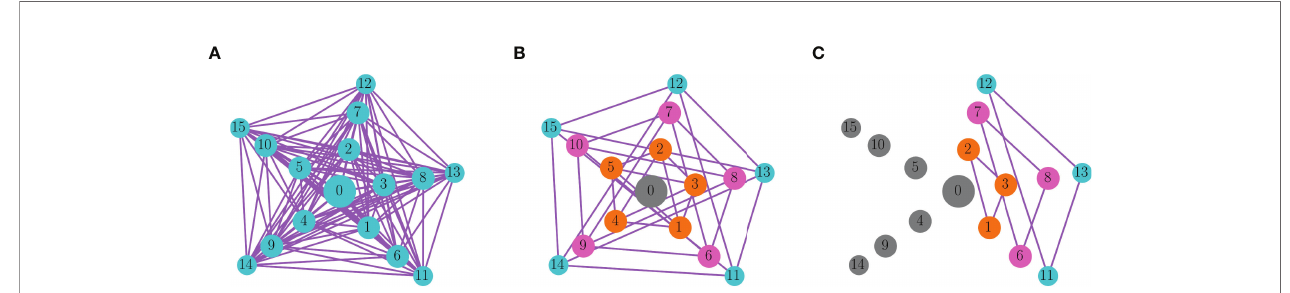
FIGURE 7 | Functional network graphs for a multi-arm network of pseudo-plateau bursters. Nodes of the same color are synchronized, and the edges indicate synchronization of the connected nodes. Gray nodes are not synchronized with any other node. (A) Of the 100 trials that start from randomized initial conditions, 26 resulted in complete synchronization of the network. (B) In 41 trials, each ring of nodes (the same distance from the center cell) synchronized, but nodes in different rings did not. (C) In 33 trials, subgraphs of the rings were synchronized. This graph shows one